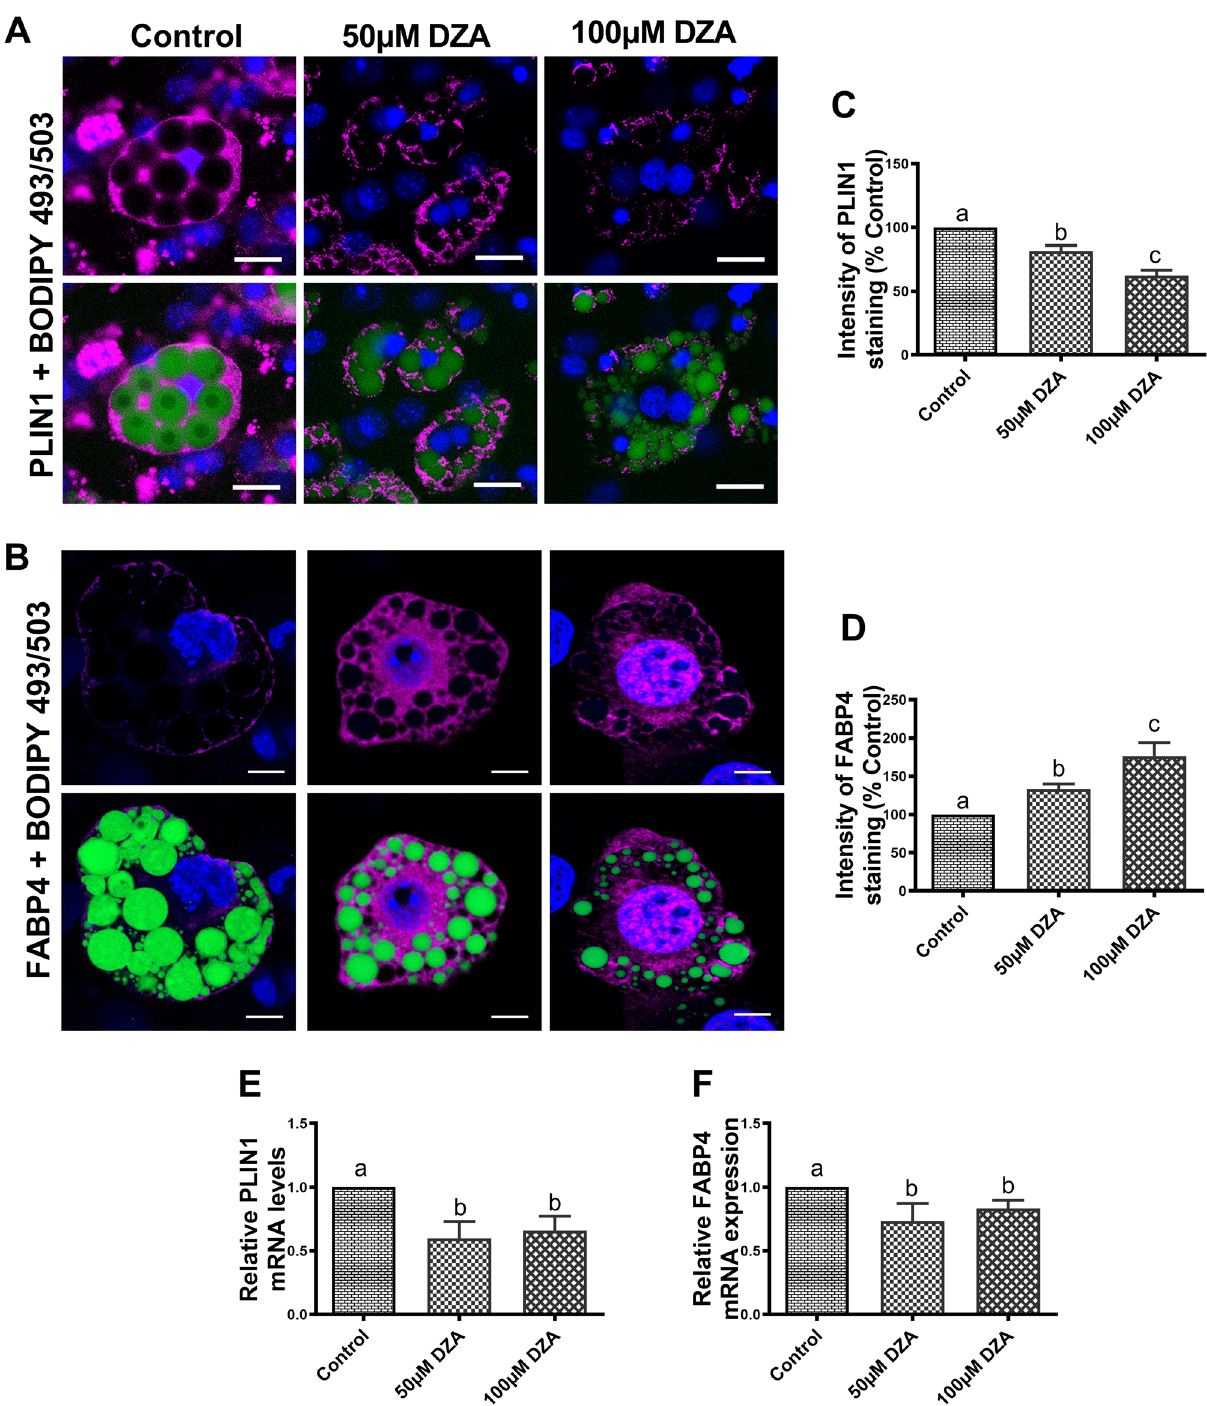
Figure 5. DZA modulates the expression of adipocyte-specific proteins. Representative immunofluorescence image of ( A ) PLIN1 and ( B ) FABP4 in BODIPY 493/503 and DAPI stained control and DZA-treated 3T3-L1 adipocytes (Scale bar—20 µm). ( C ) Fluorescence intensity of PLIN1 and ( D ) FABP4 in representative DZA- treated cells normalized to % of control cells, n = 4 experiments; images of 30 random cells from each treatment group per experiment were captured using Keyence BZ-X810 florescence microscope (Panel A) or confocal microscope (Panel B) and analysed. Relative mRNA expression levels of ( E ) PLIN1 and ( F ) FABP4 in control and DZA-treated 3T3-L1 adipocytes (n = 6). Data are presented as the mean ± SEM; values not sharing a common letter significantly differ from each other at p ≤